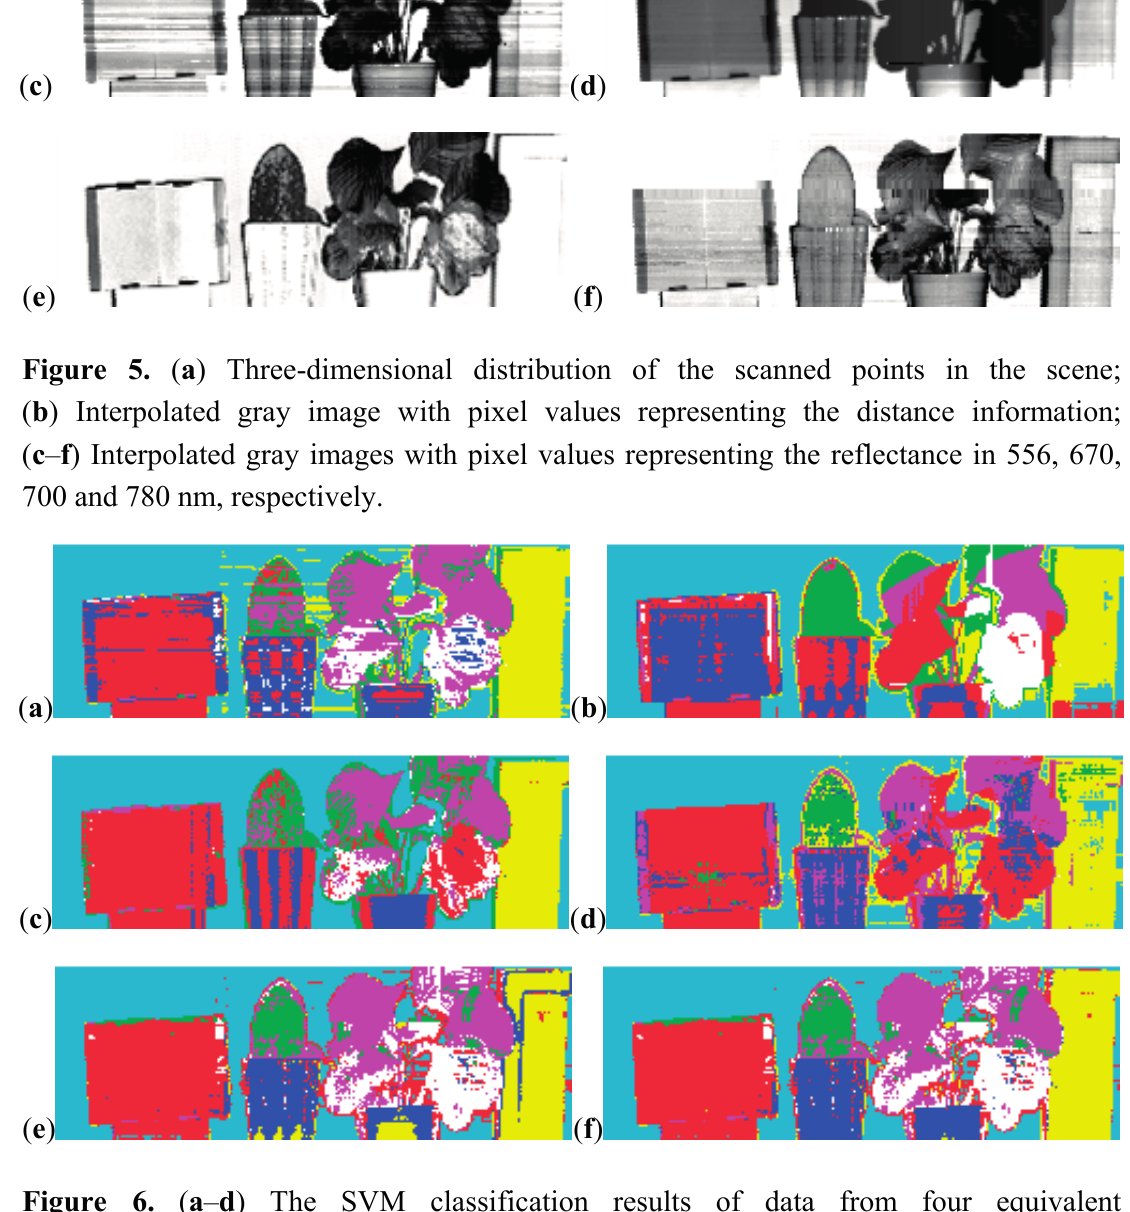
Figure 6. ( a – d ) The SVM classification results of data from four equivalent single-wavelength LiDAR systems of 556, 670, 700, and 780 nm, respectively; ( e ) The SVM classification result of data from the equivalent multispectral image with four bands; ( f ) The SVM classification result of data from the MSL